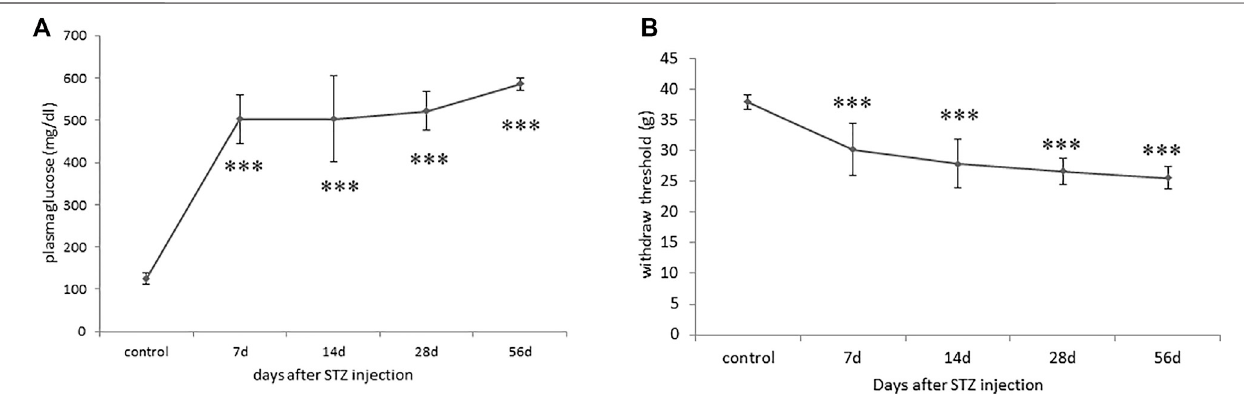
FIGURE 1 | Progression of blood glucose levels and mechanical allodynia phenotype in streptozotocin (STZ)-induced diabetic (DM) rats. (A) Hyperglycaemia indicated by signi fi cant increases in blood glucose levels of DM rats throughout the 2-month experimental periods. (B) A signi fi cant reduction in levels of hindpaw withdrawalthresholdsagainstmechanicalstimuliinDMratsindicatedthedevelopmentofmechanicalallodynia.ResultsareexpressedasmeanSEMforaminimumof10 rats. Statistical signi fi cances between the baseline control and DM groups were calculated with the Mann – Whitney U test. *** p < 0.001.